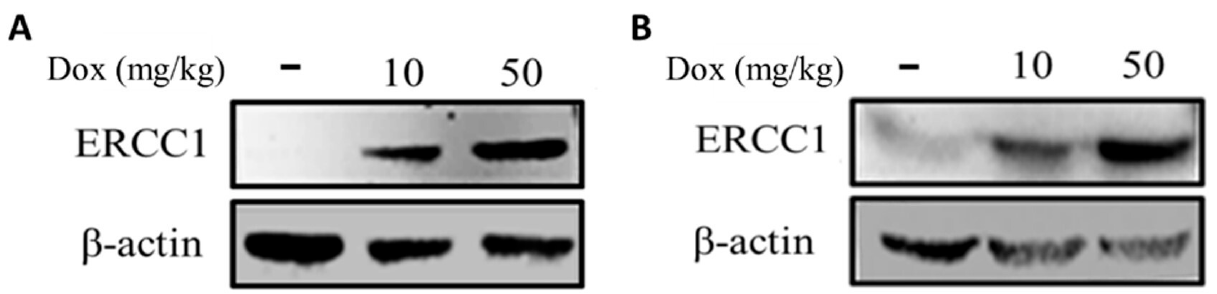
Figure 5. Analysis of ERCC1 levels in Tet-on ERCC1 tumors. ERCC1 expression in ( A ) HCT116-Tet-on and ( B ) COLO205-Tet-on tumors were determined following subcutaneous injections in mice and prior to an IP injection with doxycycline at 10 or 50 mg/kg. Tumors extracts were collected to detect ERCC1 and β -actin levels.